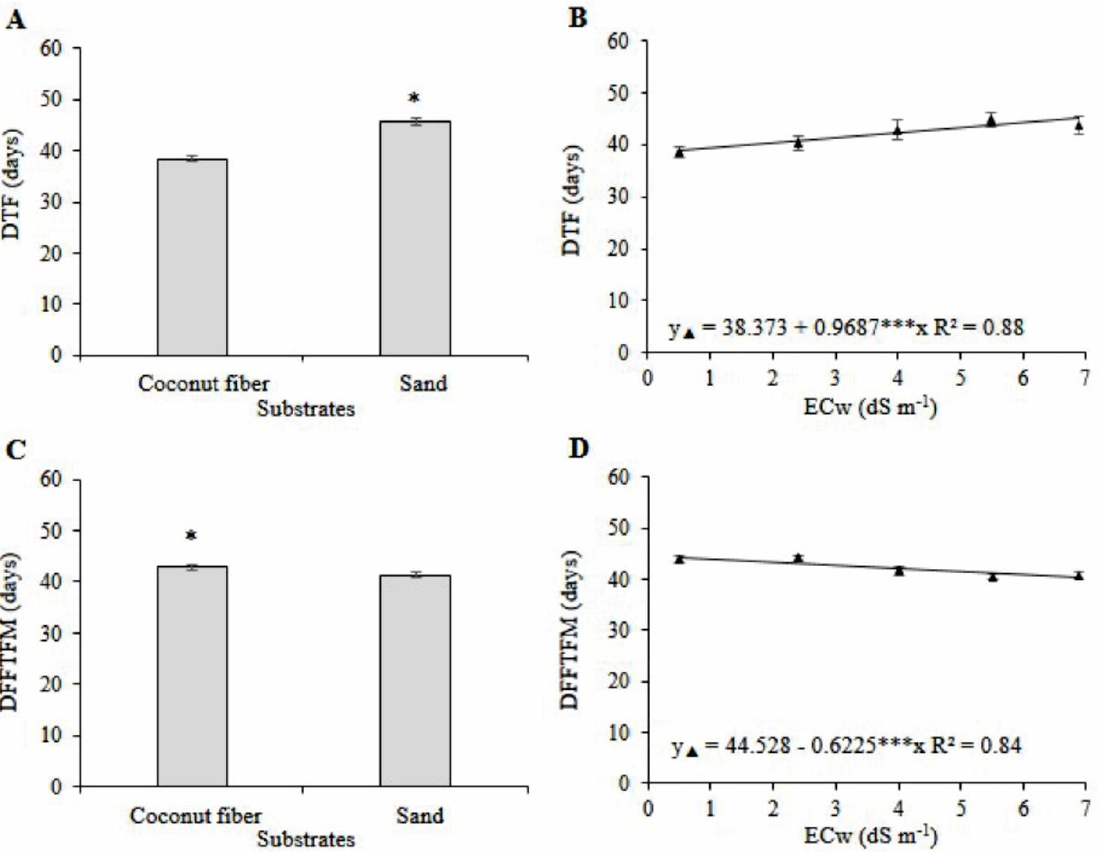
Figure 1. Regression analysis and means comparison test (Tukey, p < 0.05 and SD, n = 20) for the variables days to flowering—DTF ( A , B ) and days from flowering to fruit maturity—DFFTFM ( C , D ) of mini watermelon in hydroponic cultivation using a nutrient solution prepared with reject brine and different substrates. *** and * significant at 0.001 and 0.05 probability levels, respectively.